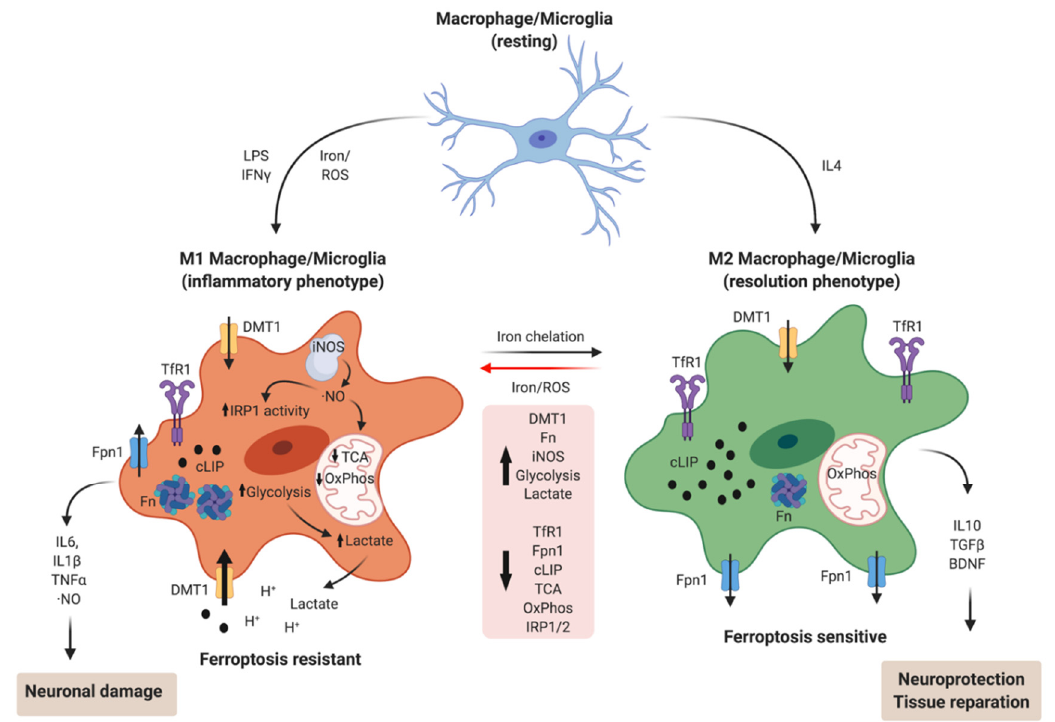
Figure 2. Iron homeostasis during macrophage/microglia M1/M2 polarization. Iron plays a central role in the balance between M1 inflammatory and M2 resolving phenotypes, stimulating M1 differentiation or converting the M2 phenotype into M1. In addition, ·NO generated by M1 macrophages/microglia reshapes cellular iron homeostasis, diminishing the cytosolic labile iron pool (cLIP) and reducing mitochondrial oxidative metabolism, thus conferring resistance to ferroptosis. Conversely, the M2 phenotype is ferroptosis-prone because of higher cLIP, energy dependence on oxidative phosphorylation, and the production of lipid oxidation products. Created with BioRender.com.